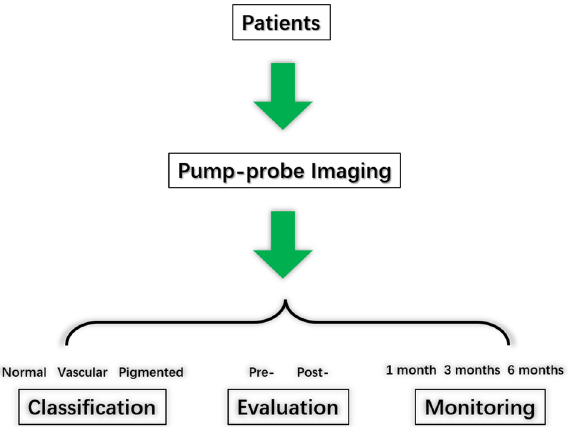
Figure 7. In vivo pump-probe imaging and classification-evaluation-monitoring